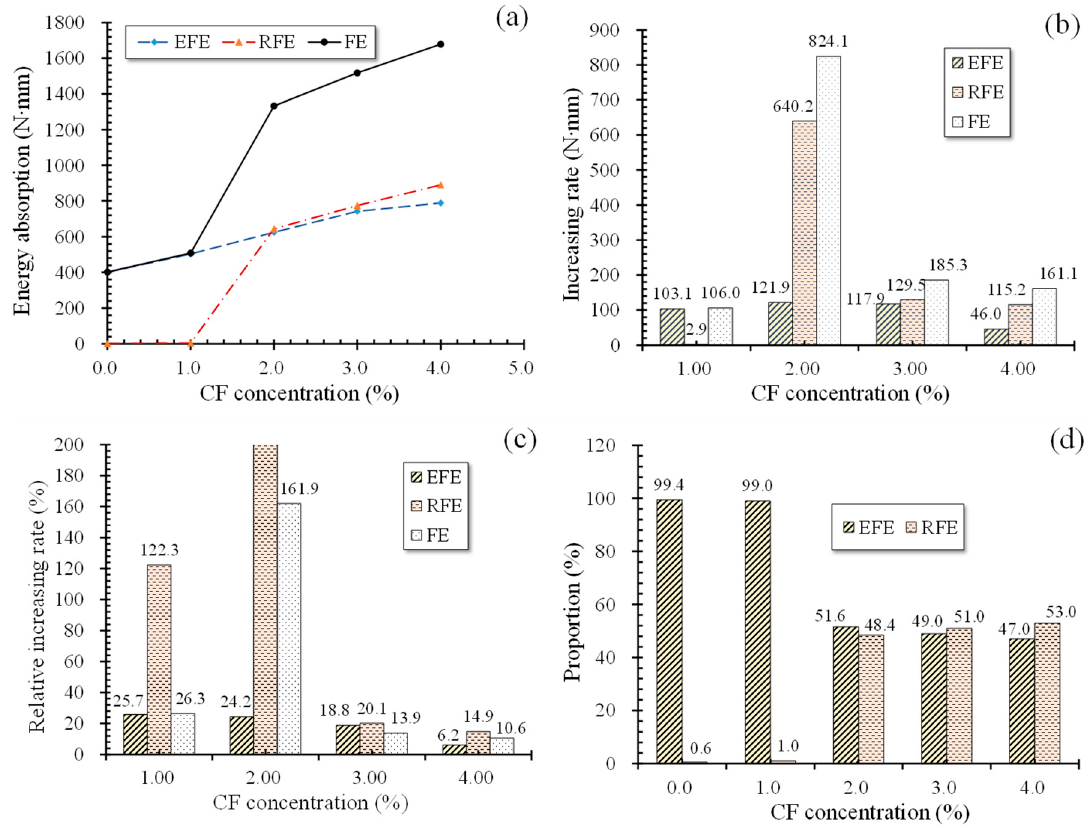
Figure 14. Energy absorption at 28 days. ( a ) Energy absorption curves; ( b ) energy absorption increasing rate; ( c ) energy absorption relative increasing rate; ( d ) proportion of EFE and RFE in FE.